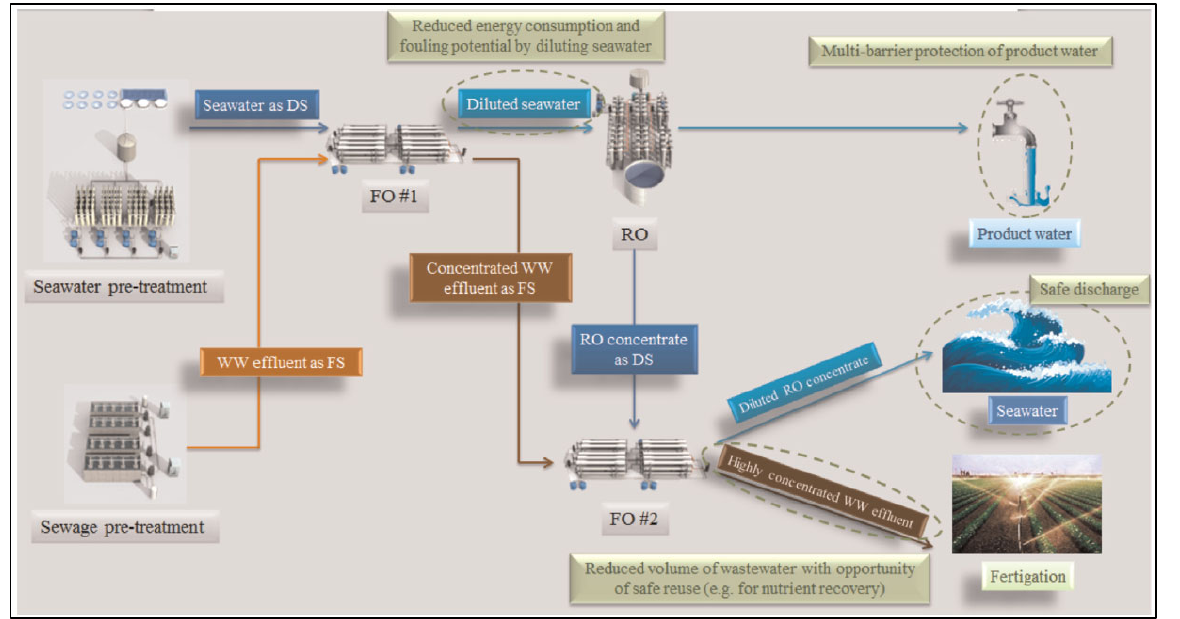
Figure 5. Schematic diagram of the osmotic dilution forward osmosis–reverse osmosis (FO–RO) desalination hybrid pilot plant [37] .